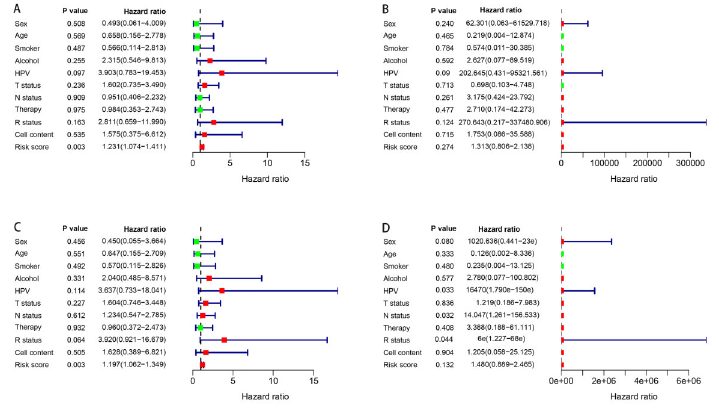
Figure 6. Univariate Cox regression forest plots of ( A ) disease-speci fi c survival (DSS) and ( C ) progression-free survival (PFS). Multivariate Cox regression forest plots of ( B ) DSS and ( D ) PFS.